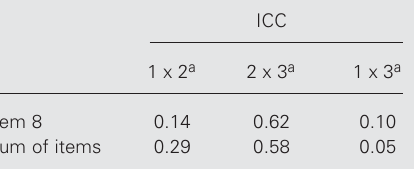
Table 1. Inter-rater reliability for total score (item 8 or sum of items) of the Portuguese version of the AIMS.